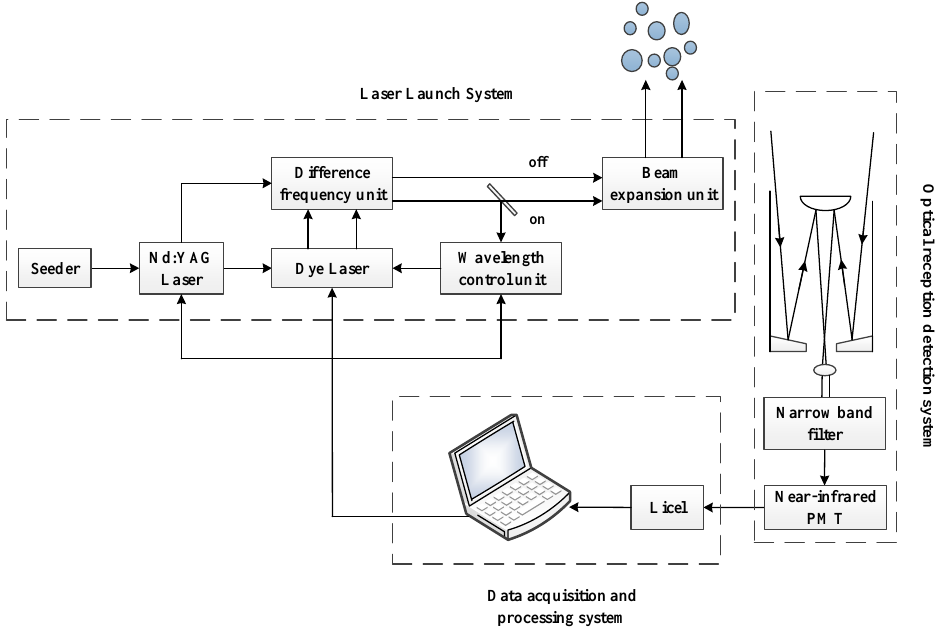
Figure 2. Configuration of our ground ‐ based CO 2 ‐ DIAL system.